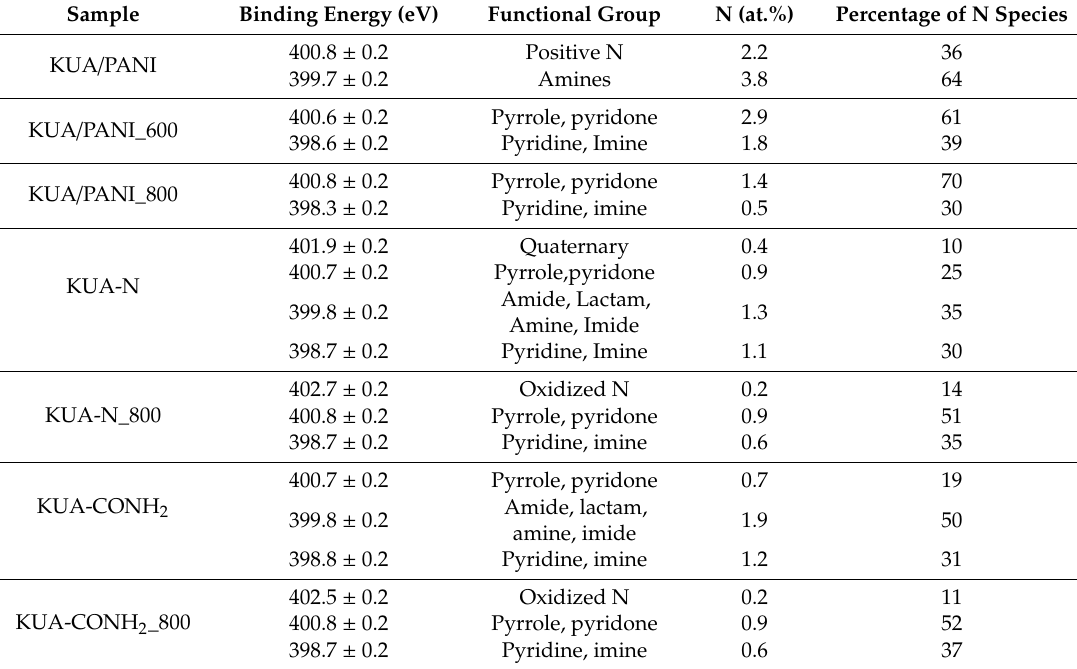
Table 2. Assignment of N1s deconvoluted curves to nitrogen functional groups.